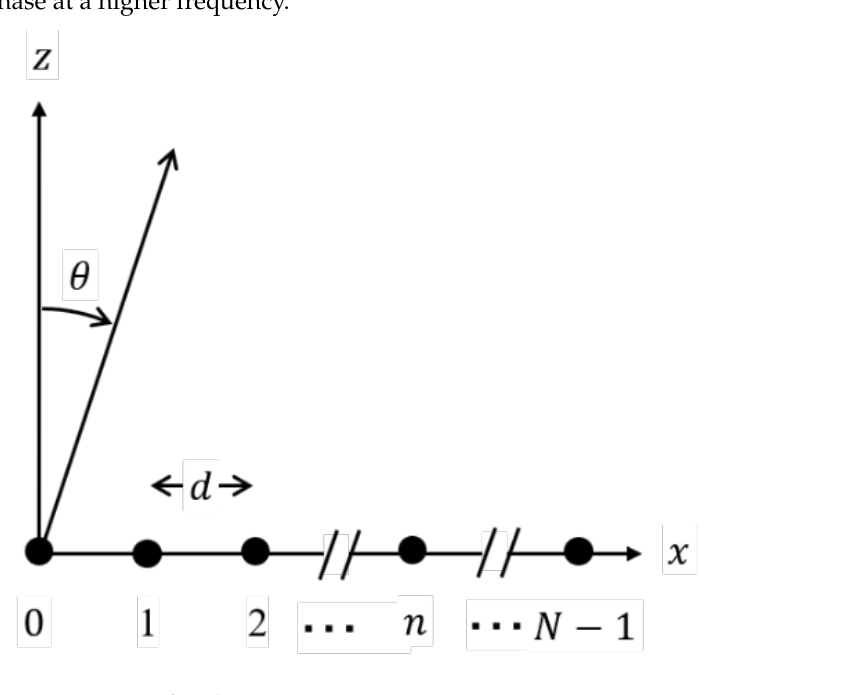
Figure 1. Layout of N element antenna array.